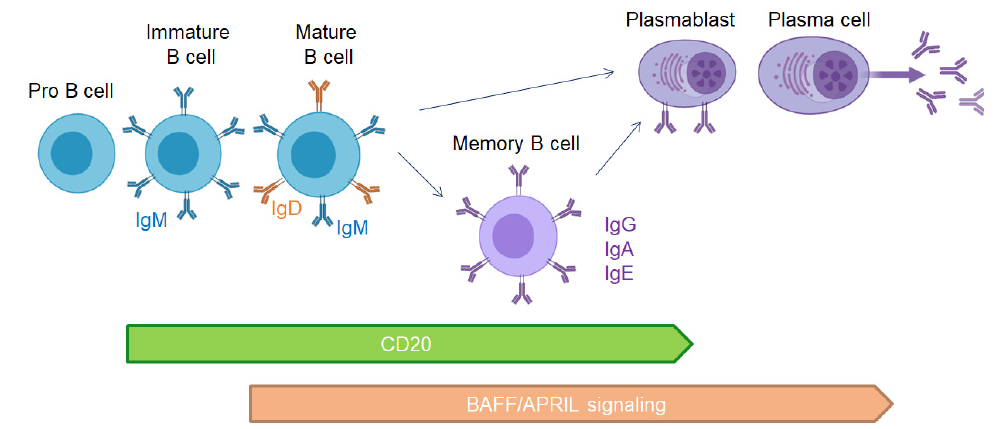
Figure 3. CD20 expression and BAFF/APRIL signaling during B cell development.